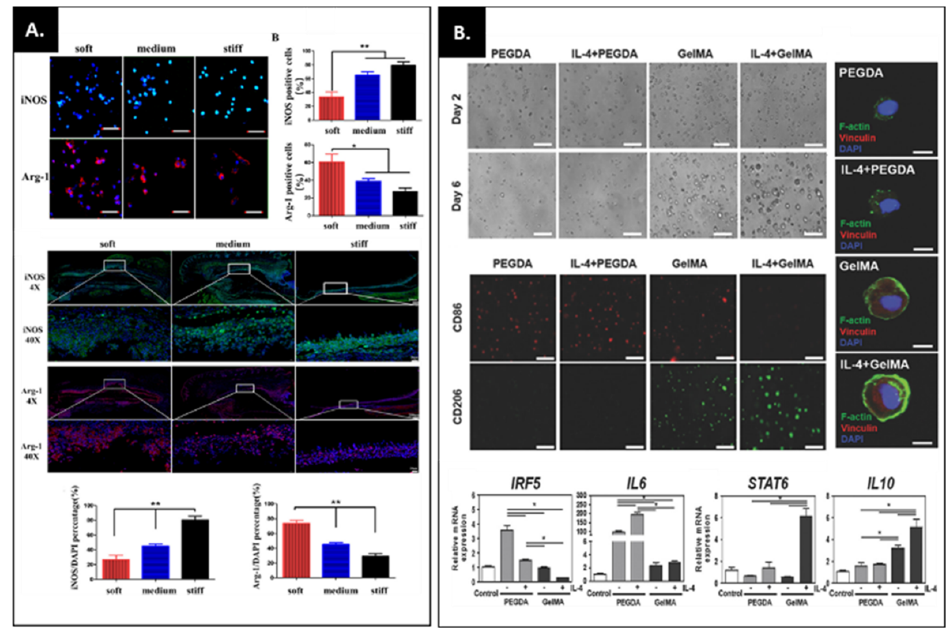
Figure 5. ( A ) Macrophage marker expression on GelMA hydrogels with different stiffnesses (iNOS; M1 marker, Arg-1; M2 marker). This study demonstrated that the soft GelMA hydrogel enhanced M2 polarization in vitro and in vivo. Adapted with permission from Ref. [102]. Copyright 2020, American Chemical Society. ( B ) Assessing macrophage morphology and phenotype in IL-4 incorporated PEGDA and GelMA hydrogels. The macrophages in PEGDA hydrogels showed clump-like cytoplasmic aggregates of F-actin, whereas macrophages in GelMA showed the presence of a prominent cortical shell. The staining images with M1 surface marker (CD86) and M2 surface marker (CD206) and qPCR of M1-related KRF5 and IL-6 and M2-related STAT6 and IL-10 indicate that the GelMA hydrogel with IL-4 enhanced M2 polarization, compared to the PEDGA-IL hydrogel. Adapted with permission from Ref. [103]. Copyright 2017, WILEY-VCH Verlag GmbH & Co. KGaA, Weinheim. * p < 0.05, ** p < 0.01.